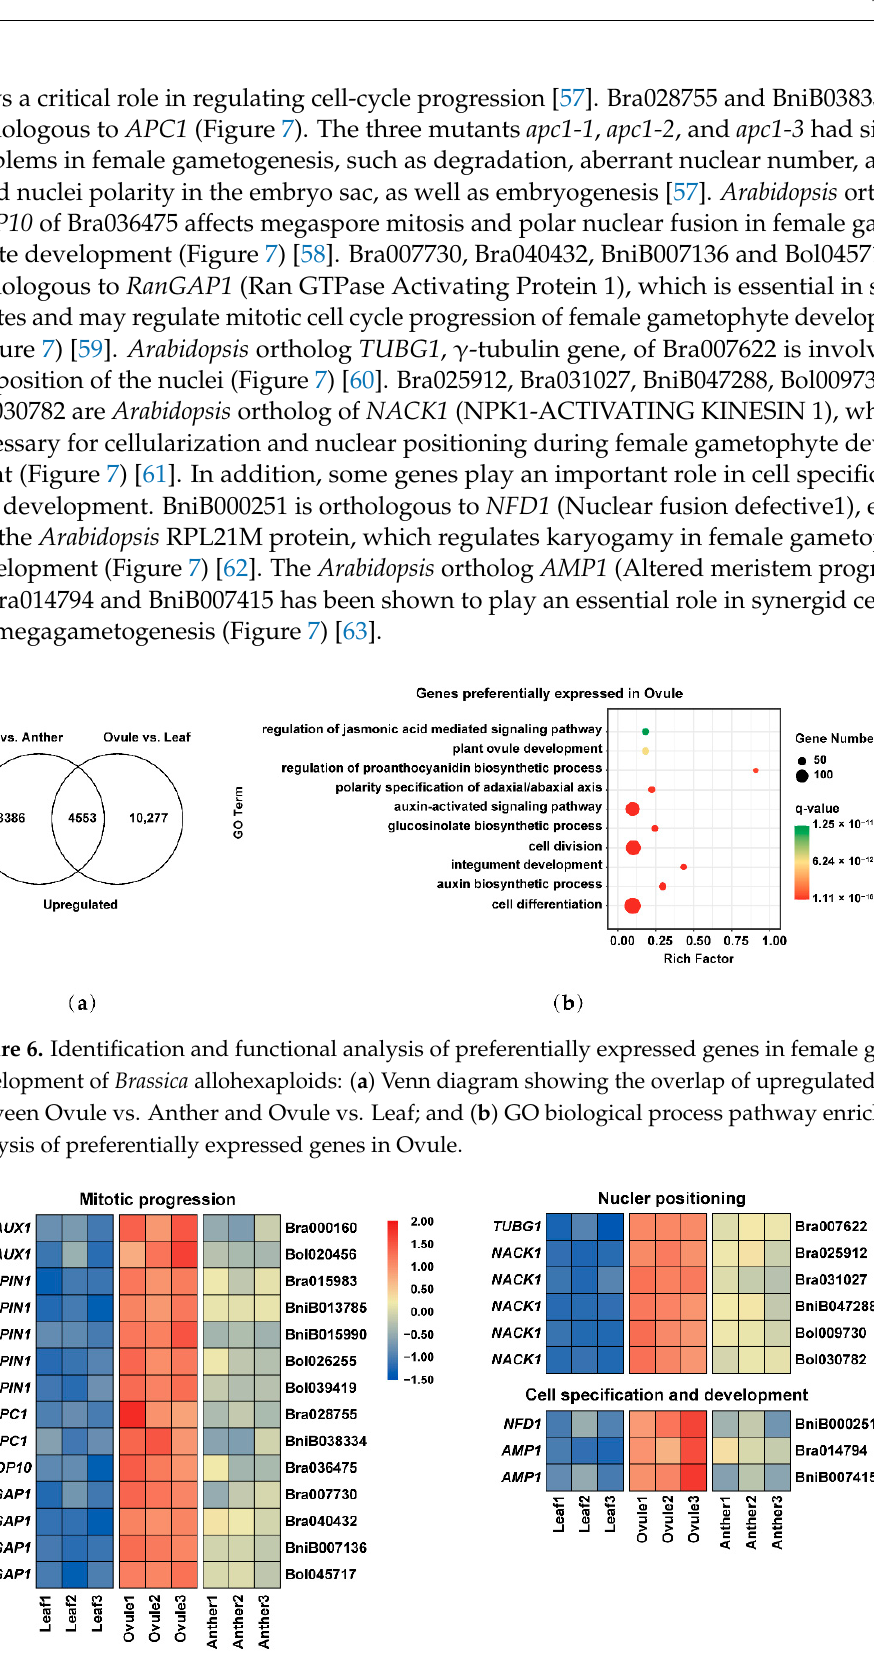
Figure 7. The expression patterns of mitotic progression, nuclear positioning and cell specification and development related genes in Anther, Ovule and Leaf of Brassica allohexaploids.